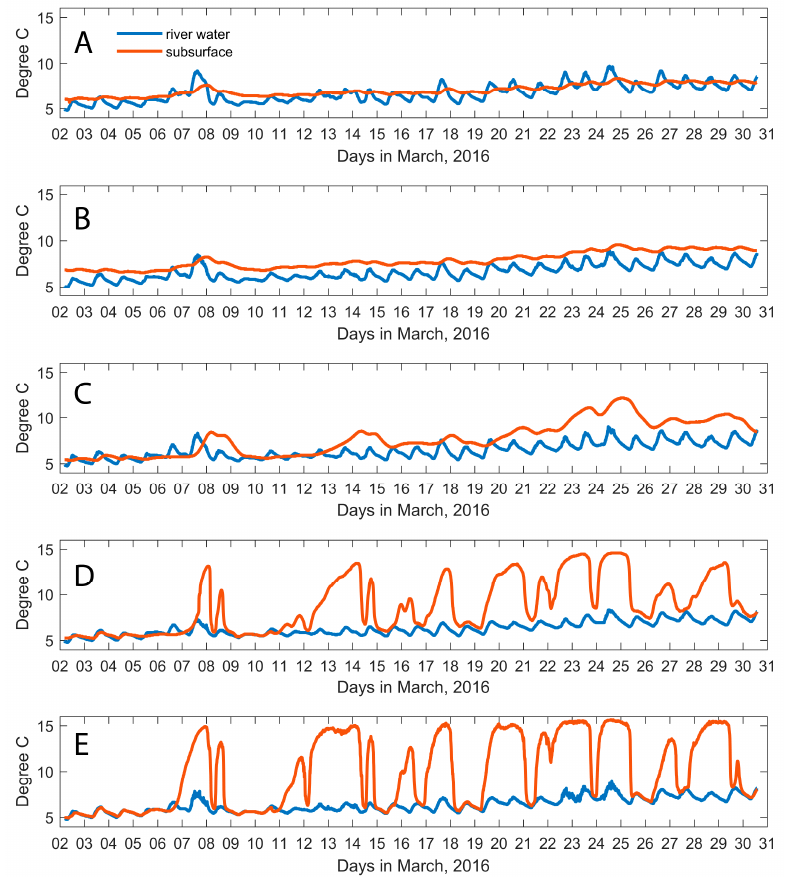
Figure 9. Time series of observed temperature at the five iButton locations.